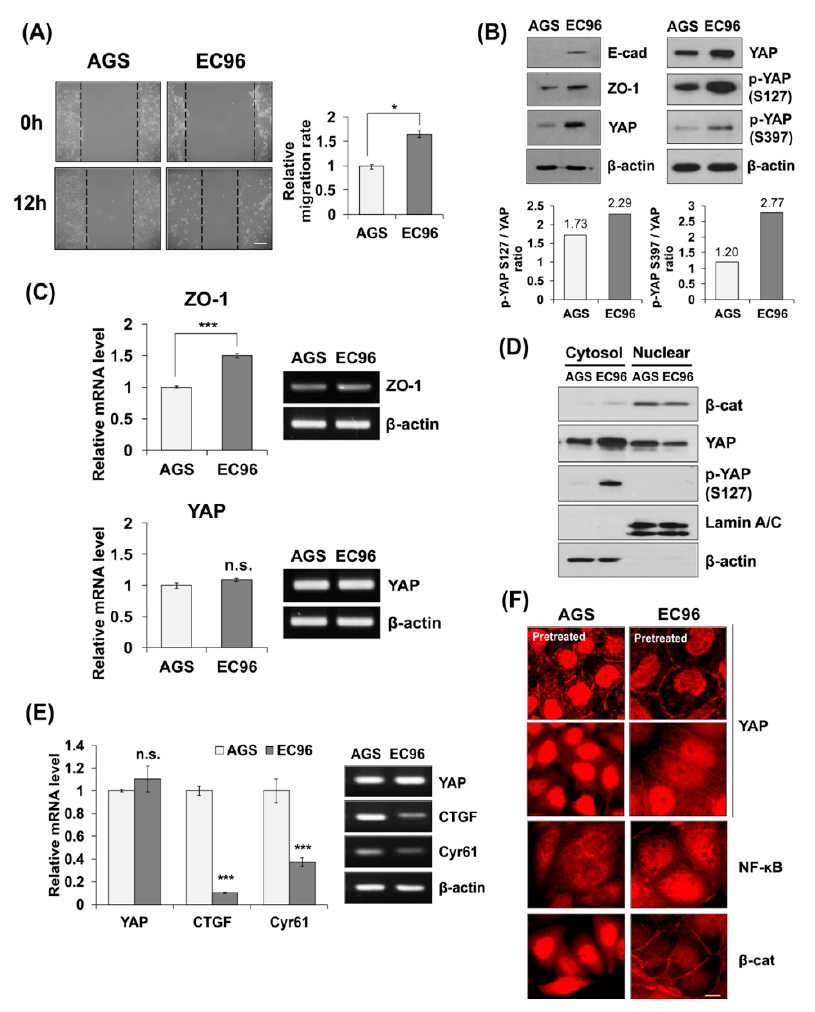
Figure 1. E ‐ cadherin expression increases YAP expression and inhibits nuclear YAP translocation. ( A ) AGS and EC96 cells were subjected to cell migration assay. Cells were incubated for 12 h and wound gaps were measured. Results are means ± SD of three experiments. * p < 0.05. Scale bar = 100 µ m. ( B ) AGS and EC96 cells were subjected to immunoblot analysis for the indicated proteins. Densitometry analysis was performed to evaluate p ‐ YAP S127/YAP and p ‐ YAP S397/YAP ratios. ( C – F ) AGS and EC96 cells were subjected to qRT ‐ PCR analysis for ZO ‐ 1 and YAP transcripts ( C ), subcellular fractionation to analyze localization of YAP ( D ), qRT ‐ PCR of YAP target genes, such as CTGF and Cyr61 ( E ), and IF analyses for YAP, NF ‐κ B, and β‐ catenin ( β‐ cat) ( F ), n.s. = not significant and *** p < 0.001 in ( C ) or ( E ). Scale bar = 10 μ m in ( F ).